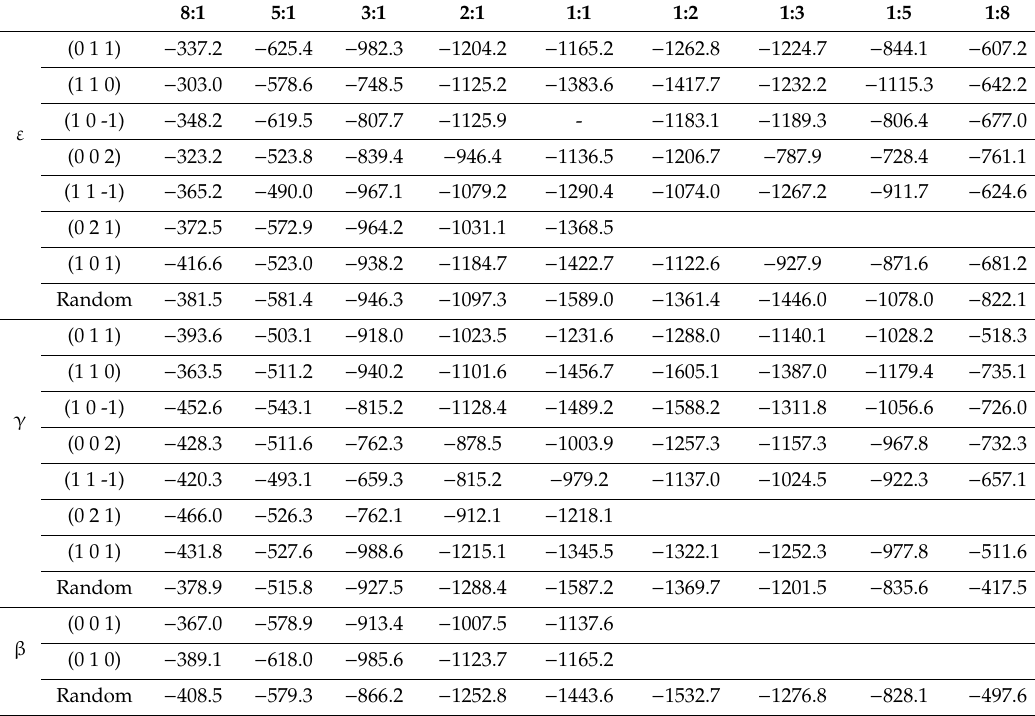
Table 5. The corrected binding energy (in kJ · mol − 1 ) of the substituted models of CL-20 / FOX-7 [10], with permission from the Journal of Mol Model,